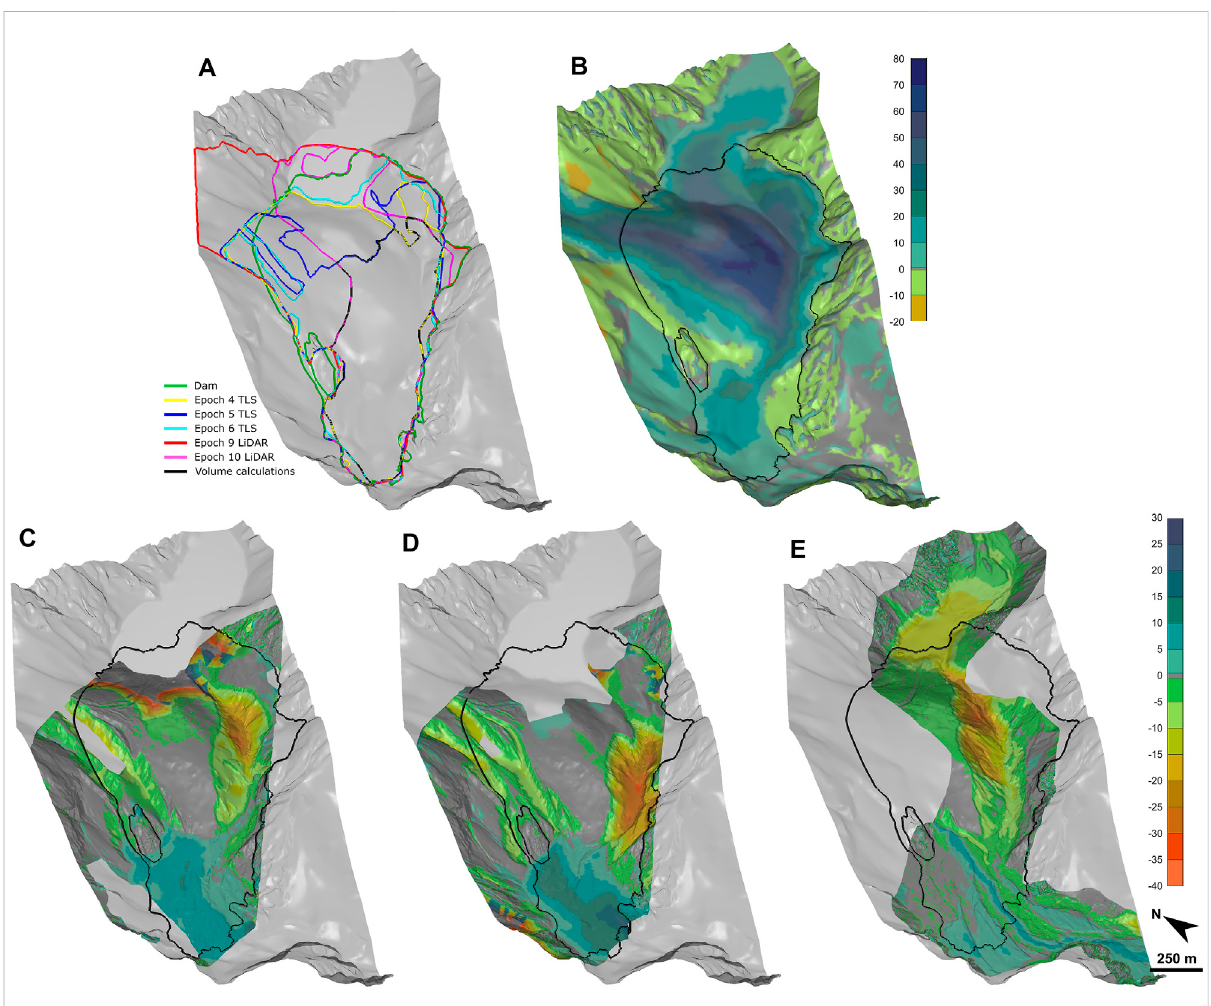
FIGURE 9 3D differencing of selected epochs. (A) Extents of TLS and aerial LiDAR datasets used for 3D point cloud differencing and volume change calculations. The maximum extent analysed is indicated by the outline of the TIN model. The green polygon represents the mapped dam deposit extent.Theareausedforvolumechangecalculations(blackoutline)istheoverlappingextentofalldatasets,whichislimitedbytheTLScoverage. (B) 3D point cloud-to-point cloud differencing conducted on the 2015 InSAR-adjusted DSM and 2016 epoch 2 LiDAR DEM), and (C – E) the TLS DEM and aerial LiDAR DEM datasets bracketing the two 2017 (C – D) and one 2018 (E) signi fi cant partial breach events (see Table 3 for details). This view is looking upstream at the dam (black